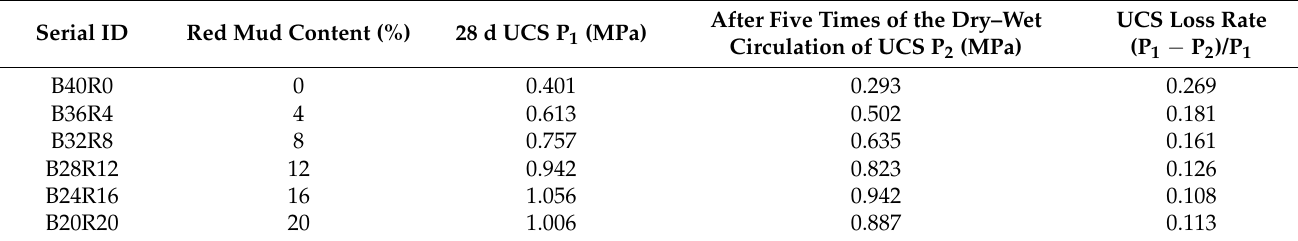
Table 6. Dry–wet cycling test results of red mud foam lightweight